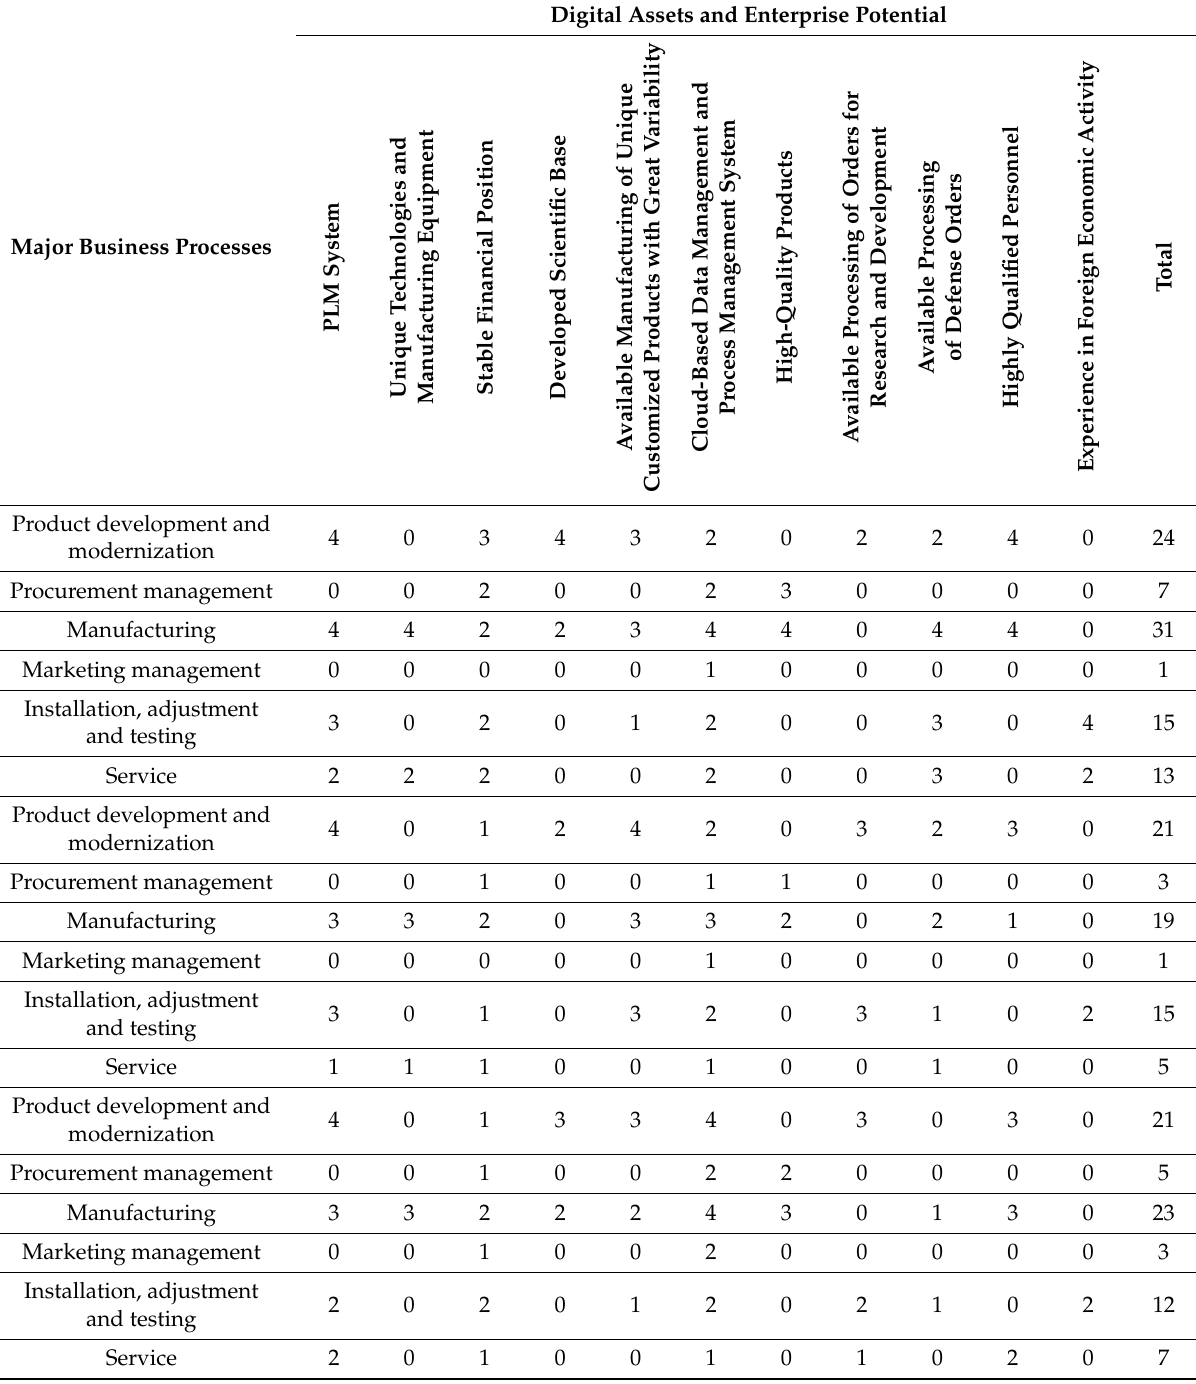
Table 3. Assessment of the use of digital assets in the implementation of major business processes of an instrumentation